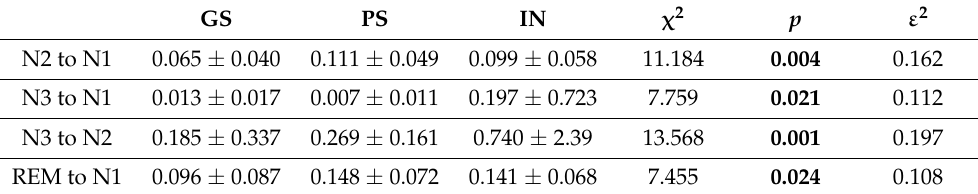
Table 4. Frequency of arousals from specific sleep states in the three groups.